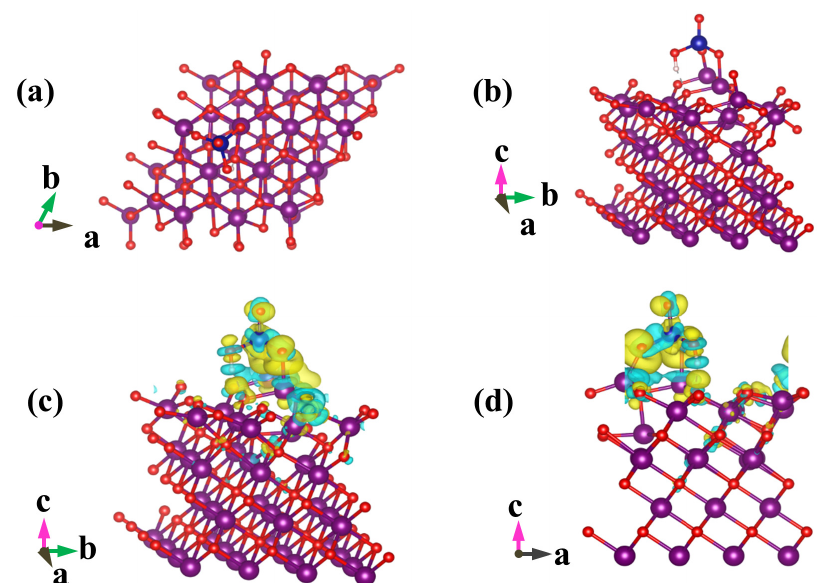
Figure 5. Effect of pH on the removal of Cr(VI) in solution: pH = 3–9; T = 13 h; m = 0.01 g; V = 15 mL; C 0 = 100 mg L − 1 .